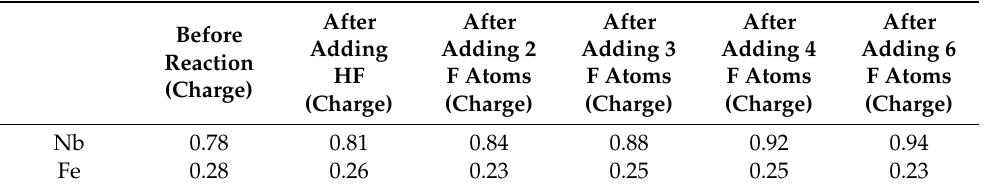
Table 2. Hirshfeld charge analysis of Nb and Fe before and after adding one HF, 2 F atoms and 3 F atoms. F Before Reaction After Adding HF (Charge)